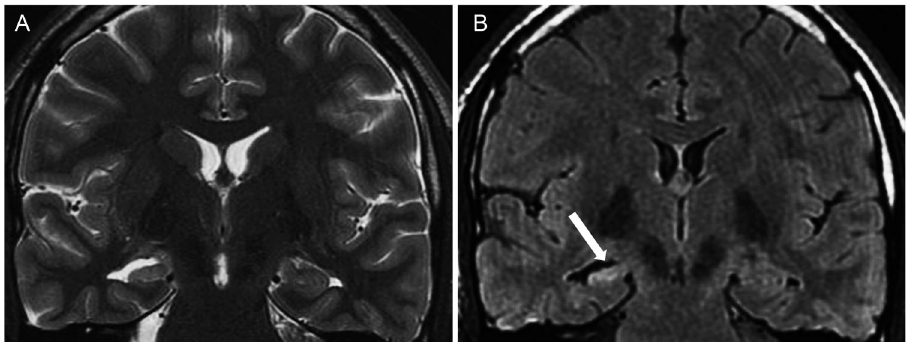
Figure 1 - Hippocampal sclerosis in a 31-year-old man with refractory right mesial temporal sclerosis. A) coronal T2-weighted image and B) coronal FLAIR images, both perpendicular to the long axis of the hippocampus. These images show a hyperintense signal, the loss of digitations and atrophy in the right hippocampal head (white